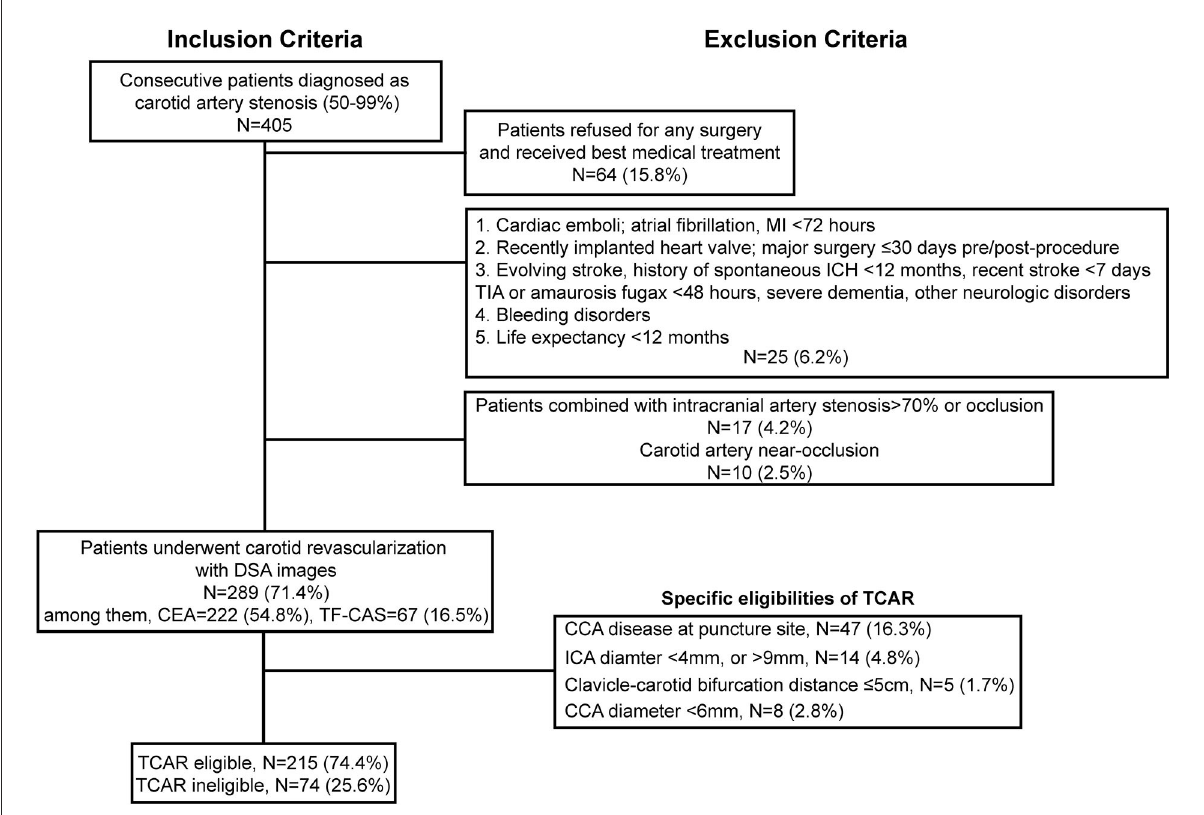
FIGURE1 Inclusion and exclusion criteria of TCAR eligibility for patients with carotid stenosis who underwent carotid revascularization. MI, myocardial infarction; ICH, intracranial cerebral hemorrhage; TIA, transient ischemic attack; DSA, Digital substraction angiography; CEA, Carotid endarterectomy; TF-CAS, Transfemoral-Carotid artery stenting; CCA, common carotid artery; ICA, internal carotid artery; TCAR, transcarotid artery